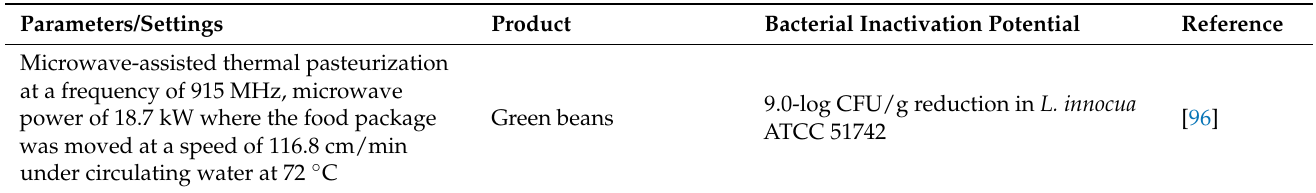
Table 6. Effect of microwave-assisted/induced sterilization with heat on bacterial inactivation in fruits/vegetable